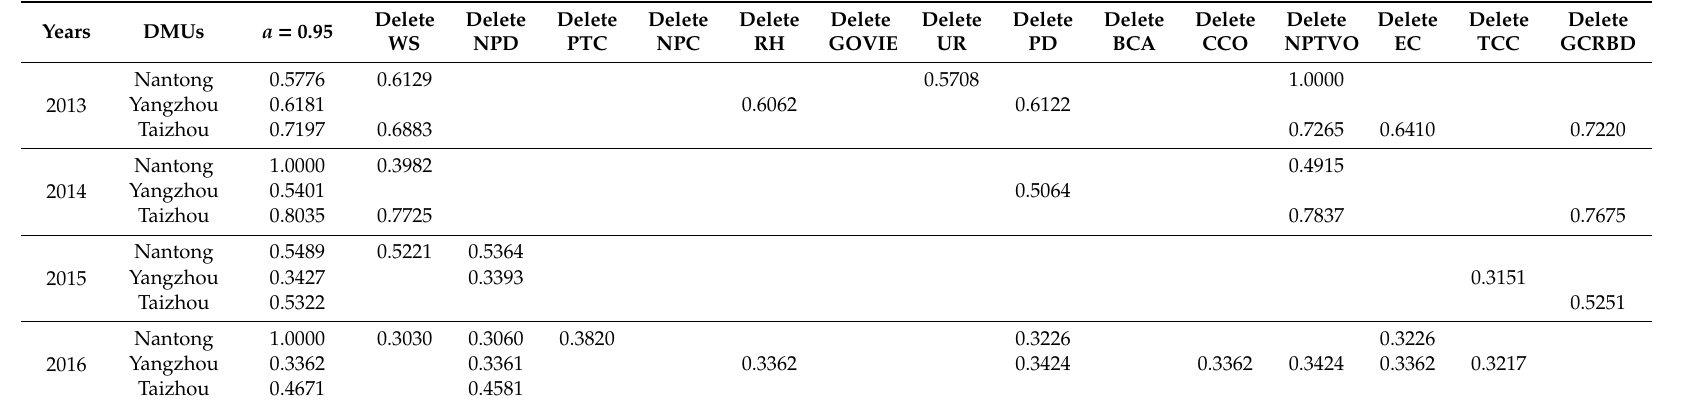
Table A14. The changes of stochastic e ffi ciency value by deleting single input variable in Central Su ( α = 0.95).